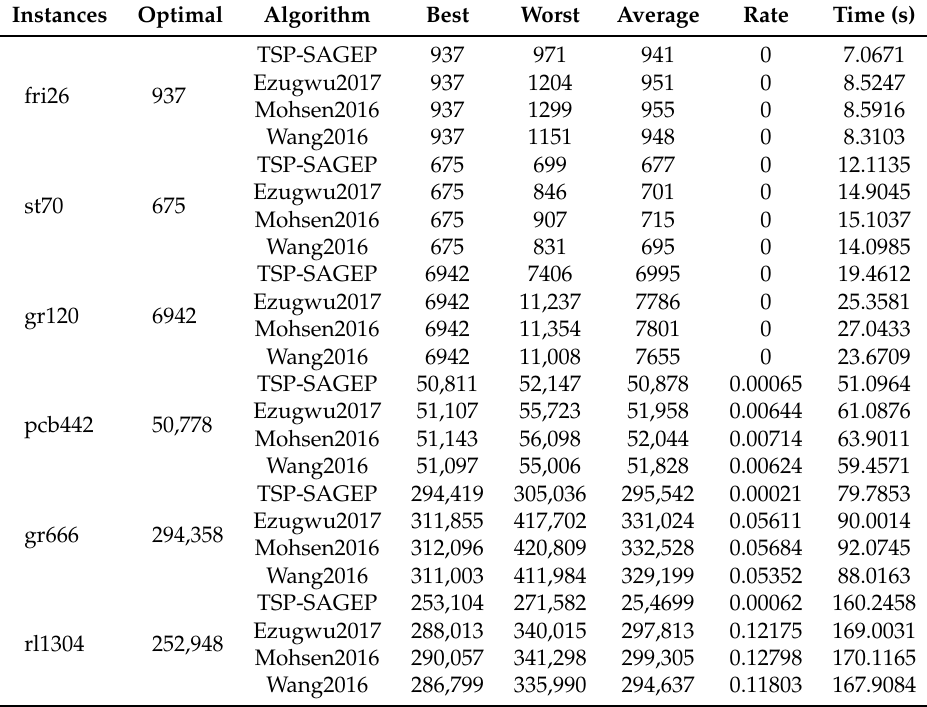
Table 4. Comparison of three measures between four